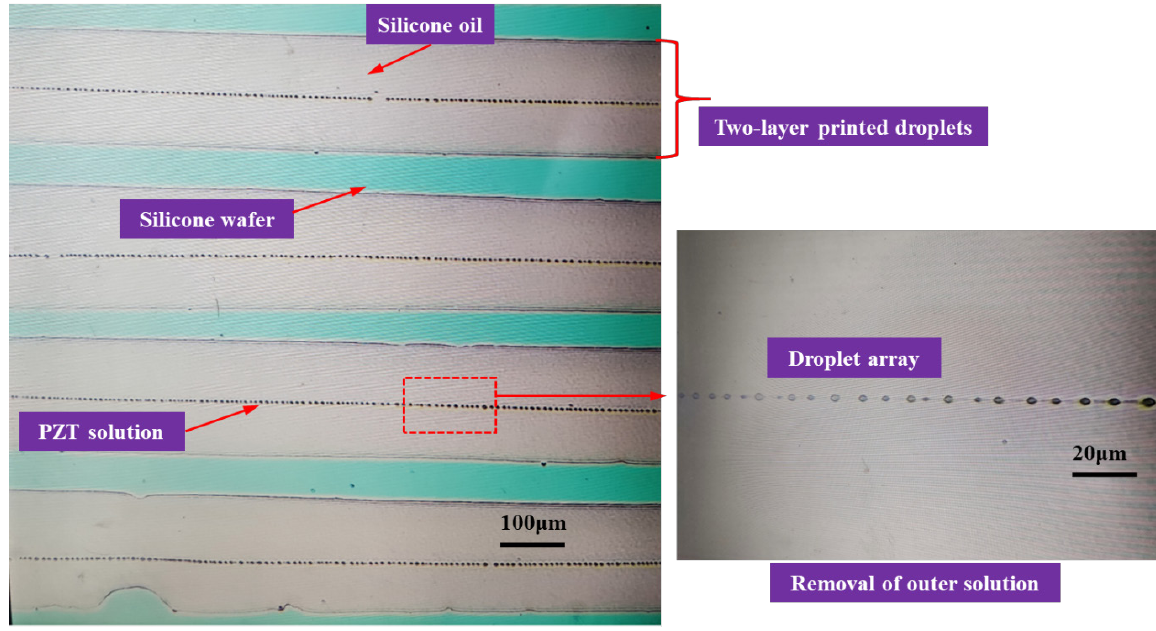
Figure 10. The DoD CE-Jet compound microdroplets structures on silicon substrate at optimized simulation parameters .